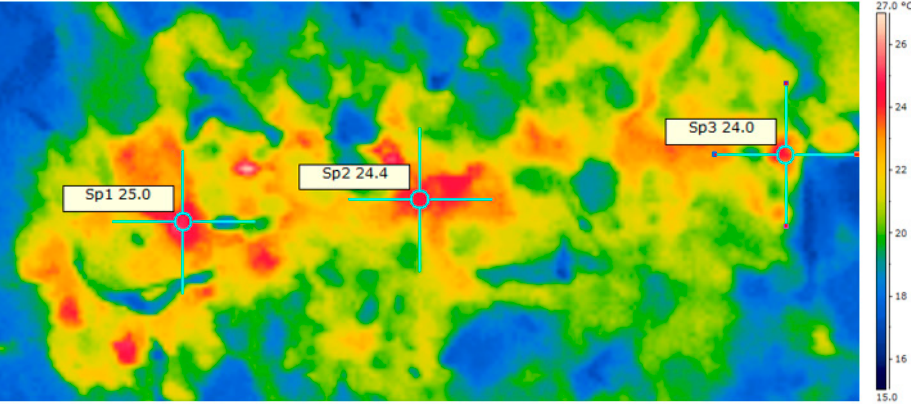
Figure 3. Thermograph from QuickReport 2.1 software with a view of materials in the chamber during mixing with CaO (RDF + 5% mass addition of CaO).